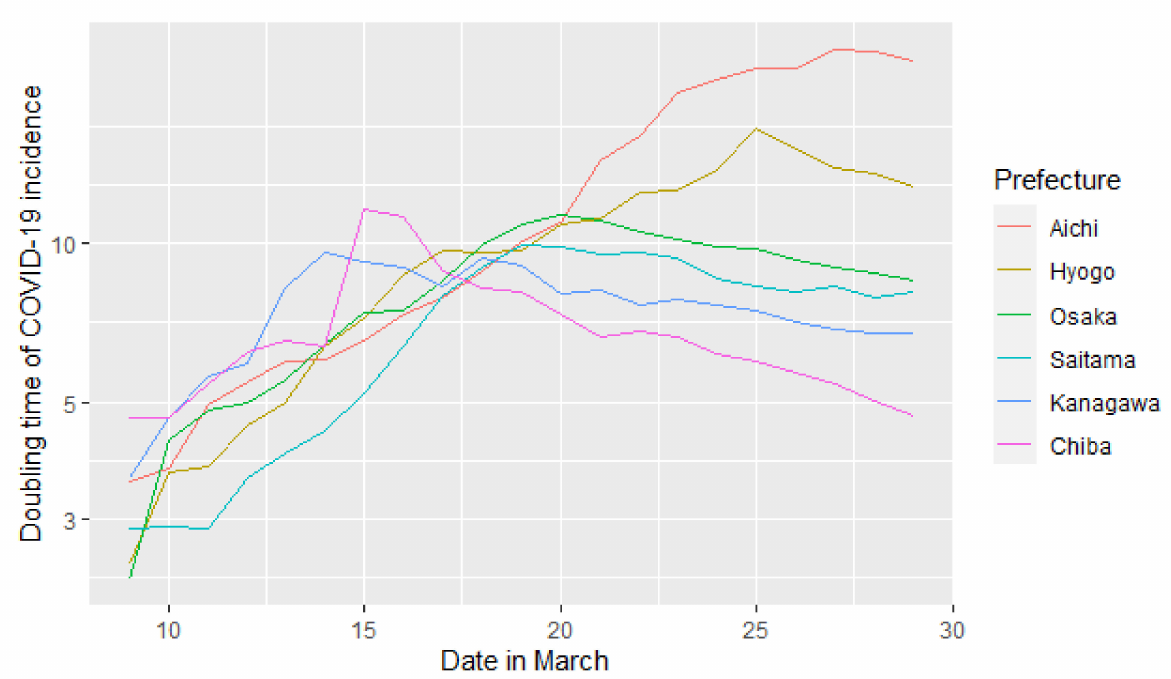
Figure 1. The 14 day moving-average of doubling time derived by counting the number of patients with the date of symptom onset beginning on 24 February (the first day of the 9th week) in each prefecture. The longitudinal axis is expressed as the natural